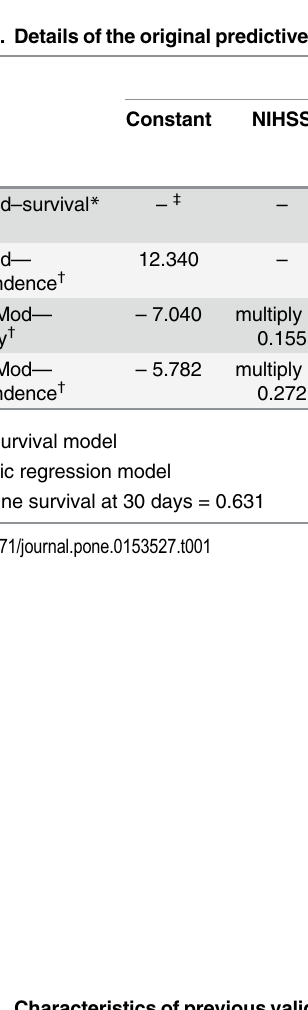
Table 2. Characteristics of previous validation